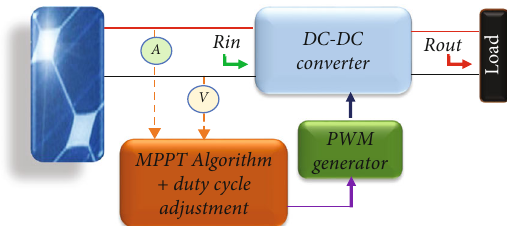
Figure 1: Schematic diagram of the complete photovoltaic system used.